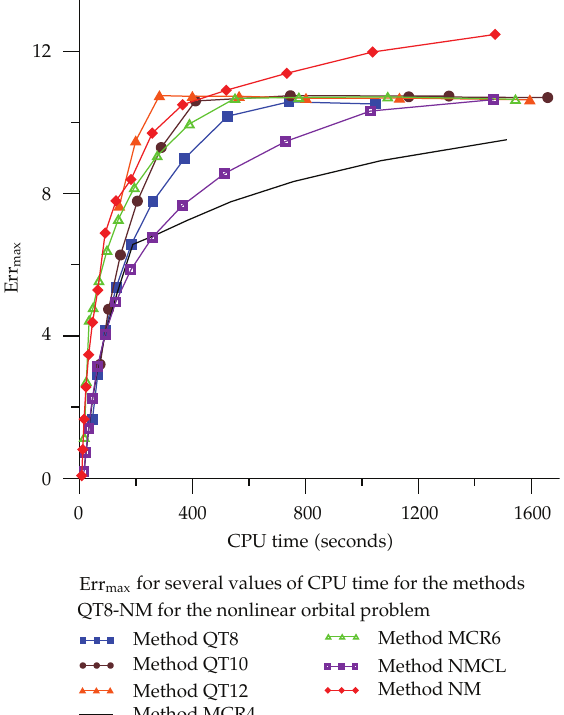
Figure 6: Accuracy (cid:4) digits (cid:5) for several values of CPU time (cid:4) in seconds (cid:5) for the nonlinear orbital problem. The nonexistence of a value of accuracy (cid:4) digits (cid:5) indicates that for this value of CPU time, accuracy (cid:4) digits (cid:5) is less than